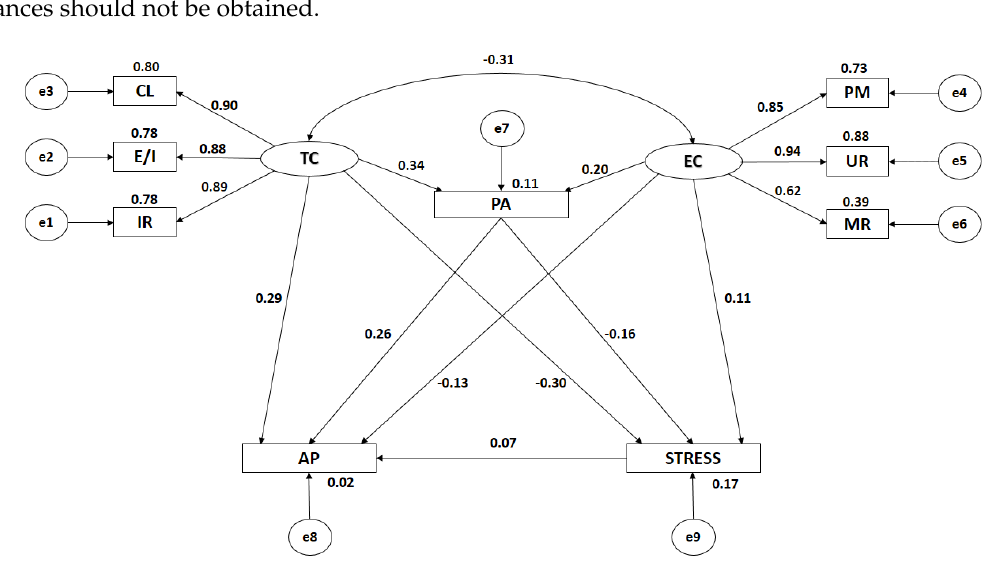
Figure 2. Structural equation model incorporating only males. Note: TC, task climate; CL, cooperative learning; E/I, effort/improvement; IR, important role; EC, ego climate; MR, member rivalry; PM, punishment of mistakes; UR, unequal recognition; PA, physical activity; AP, academic performance; and STRESS, life stress. Table 1. Structural model for males.